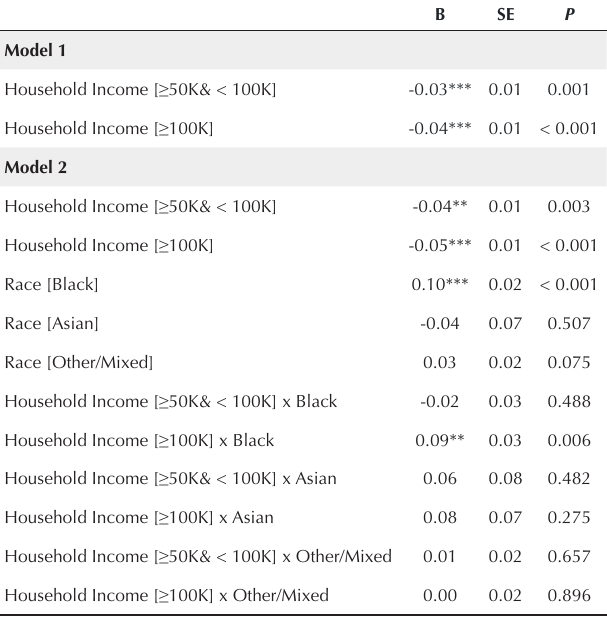
Table 2. Linear Regression on the Association Between Household Income and Perceived Discrimination in the Overall Sample